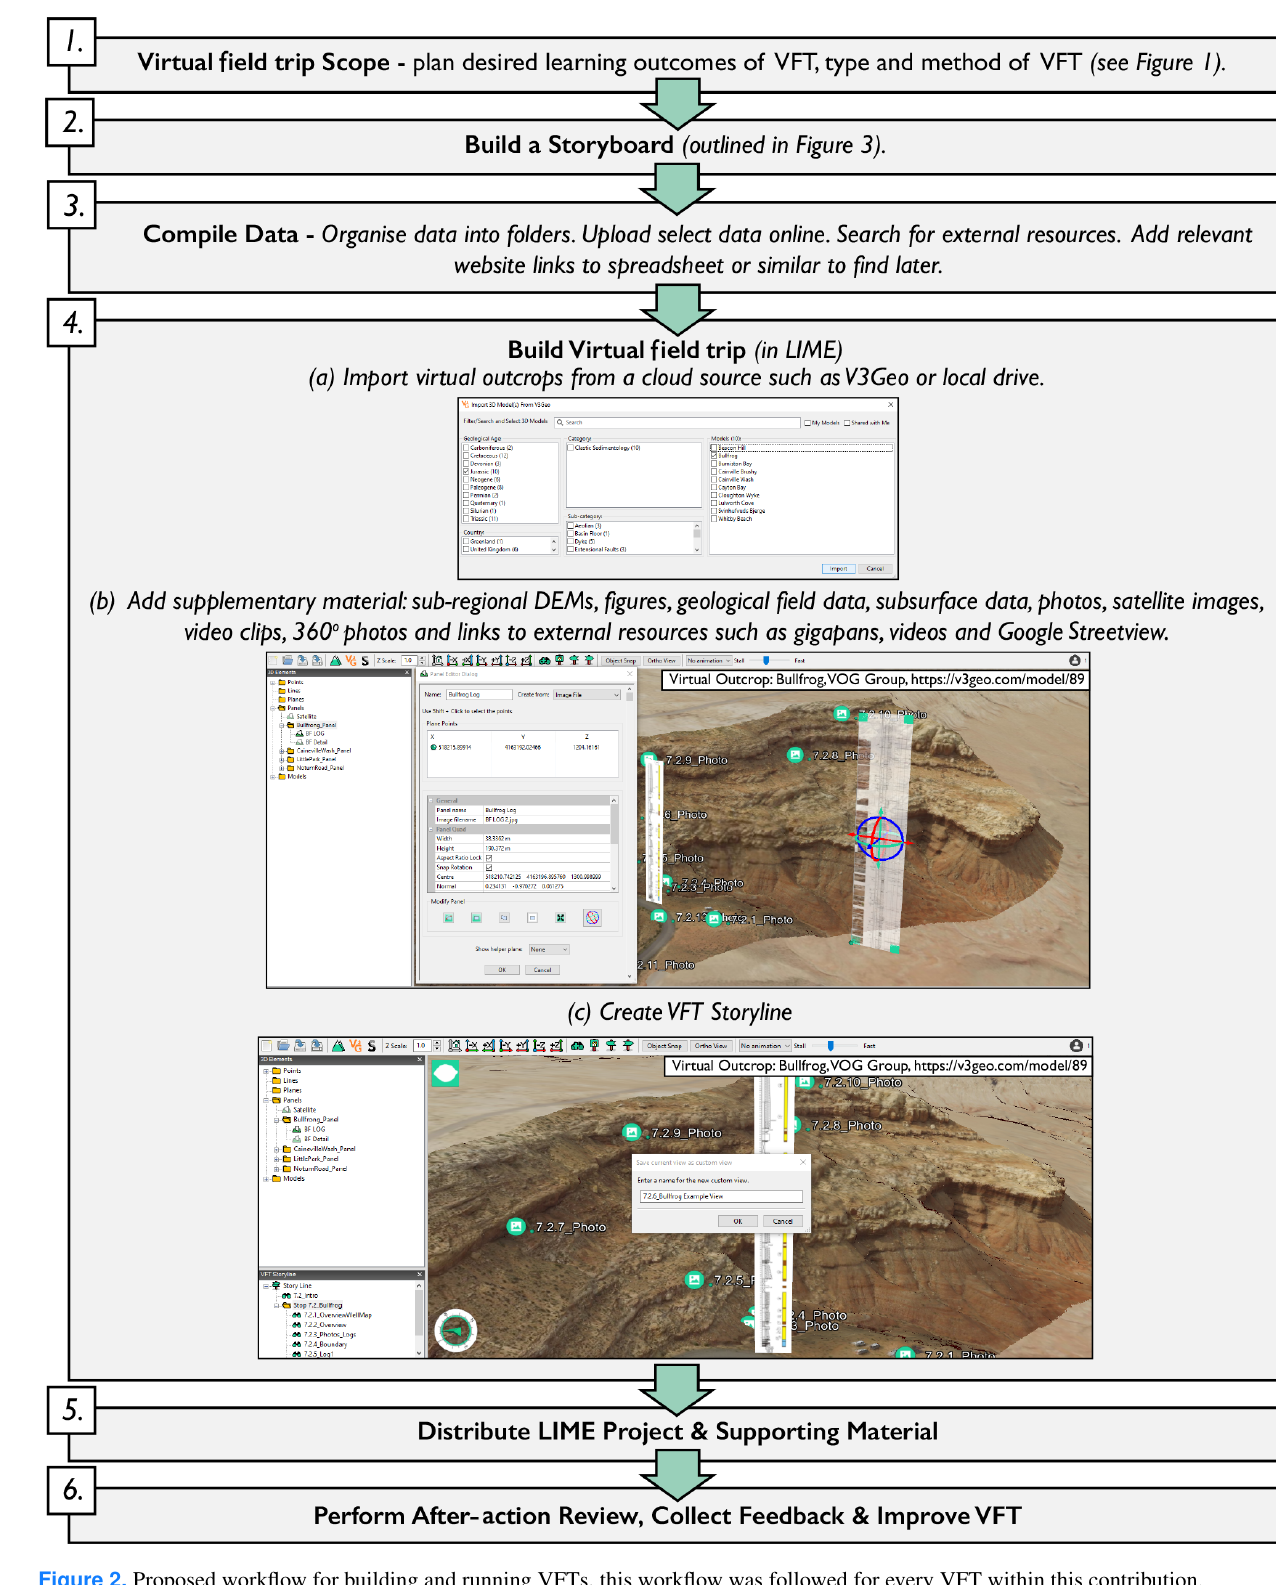
Geosci. Commun., 5, 227–249, 2022